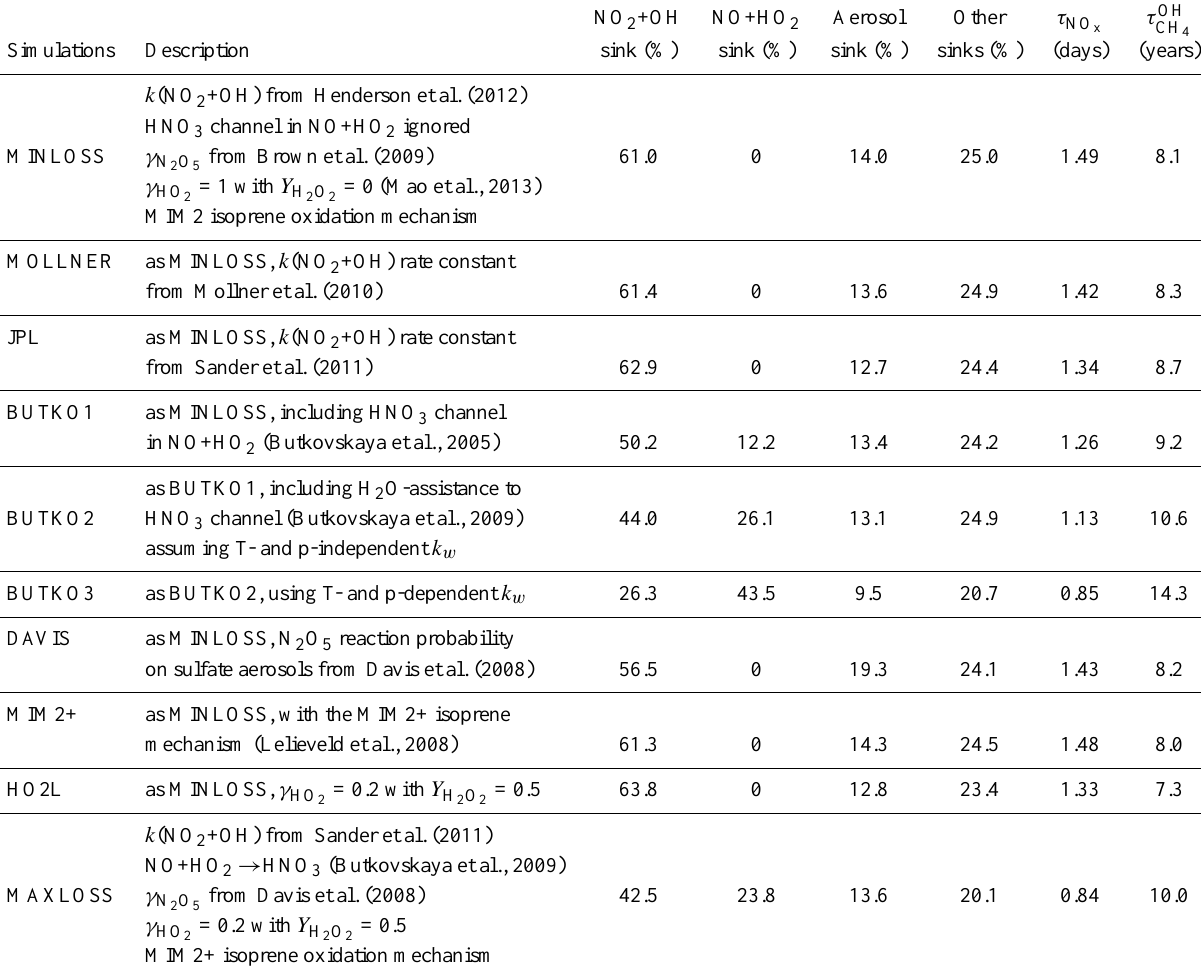
Table 1. Forward simulations conducted with the global model, with the corresponding calculated contributions of each sink process to the global tropospheric sink of NO x , the global tropospheric NO x lifetime (diurnal average, in days), and the global lifetime of methane with respect to OH-reaction in the troposphere (in